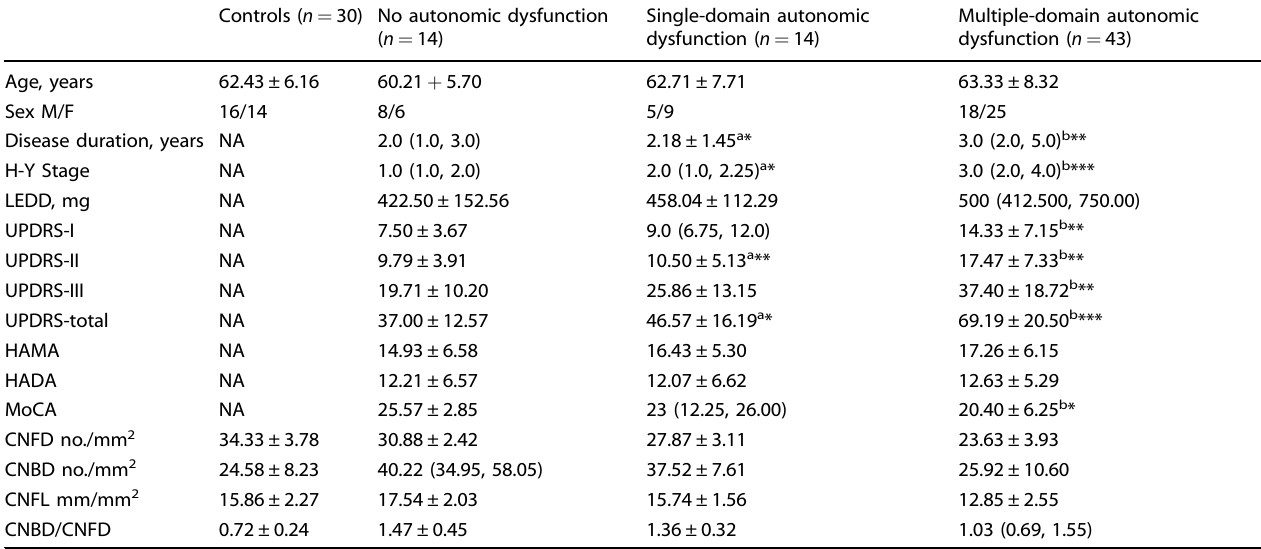
Table 1. Demographic characteristics of participants.